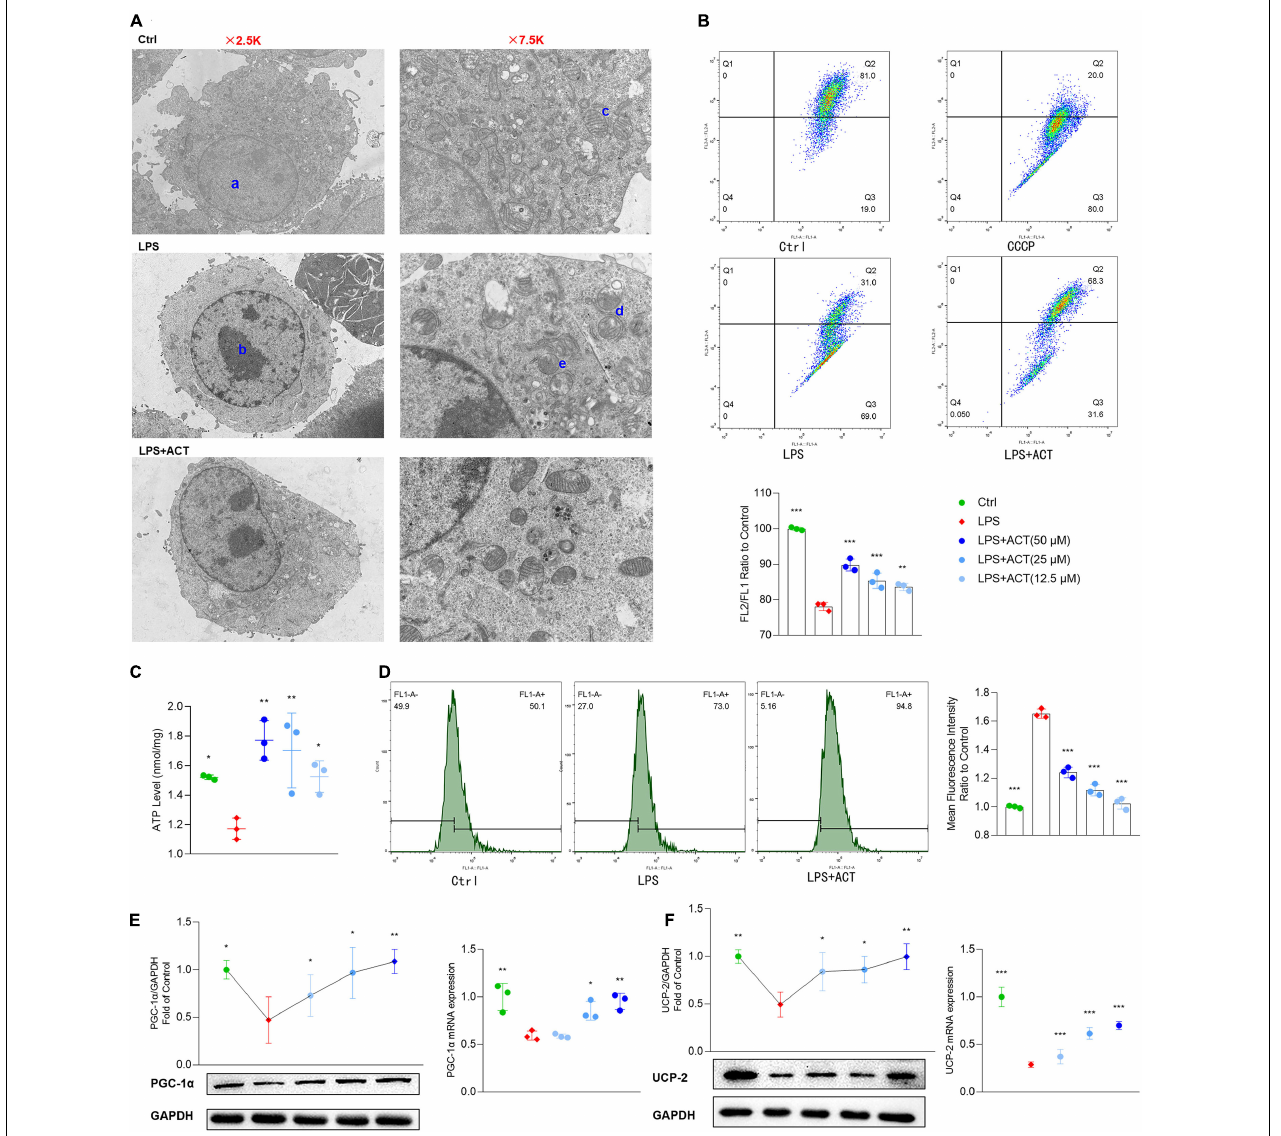
FIGURE 4 | Effects of ACT on mitochondrial function in LPS-treated BV-2 cells. (A) Ultrastructural changes in the different groups of BV-2 cells under the transmission electron microscopy. a, normal nucleus. b, nucleus chromatin condensation. c, normal mitochondria. d, mitochondrial cristae disarranged or even disappeared. e, swollen and vacuolated mitochondria. (B) The representative images and bar graph of JC-1 red and green fluorescence ratio. (C) Bar graph showing quantified statistics of ATP level. (D) The representative images of DCFH-DA staining and bar graph of intracellular ROS production. (E) ACT distinctly decreases the protein and mRNA levels of PGC-1 α . (F) ACT distinctly decreases the protein and mRNA levels of UCP-2. * P < 0.05, ** P < 0.01, *** P < 0.005, versus the LPS group. n =